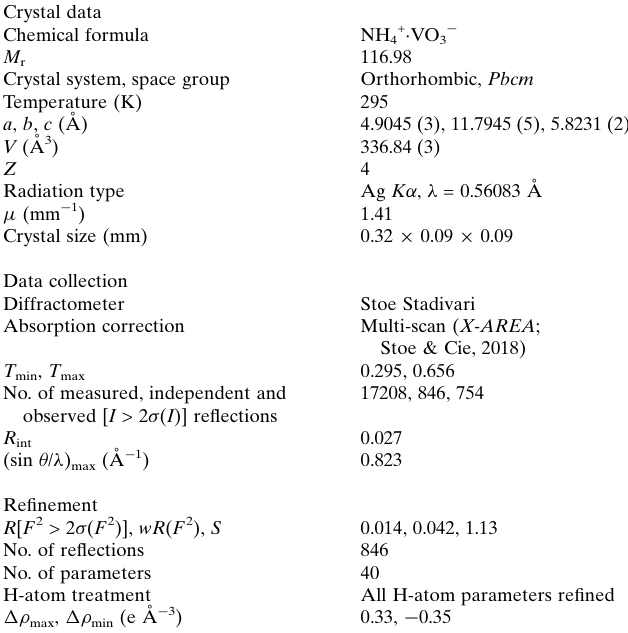
Table 3 Experimental details. Crystal data Chemical